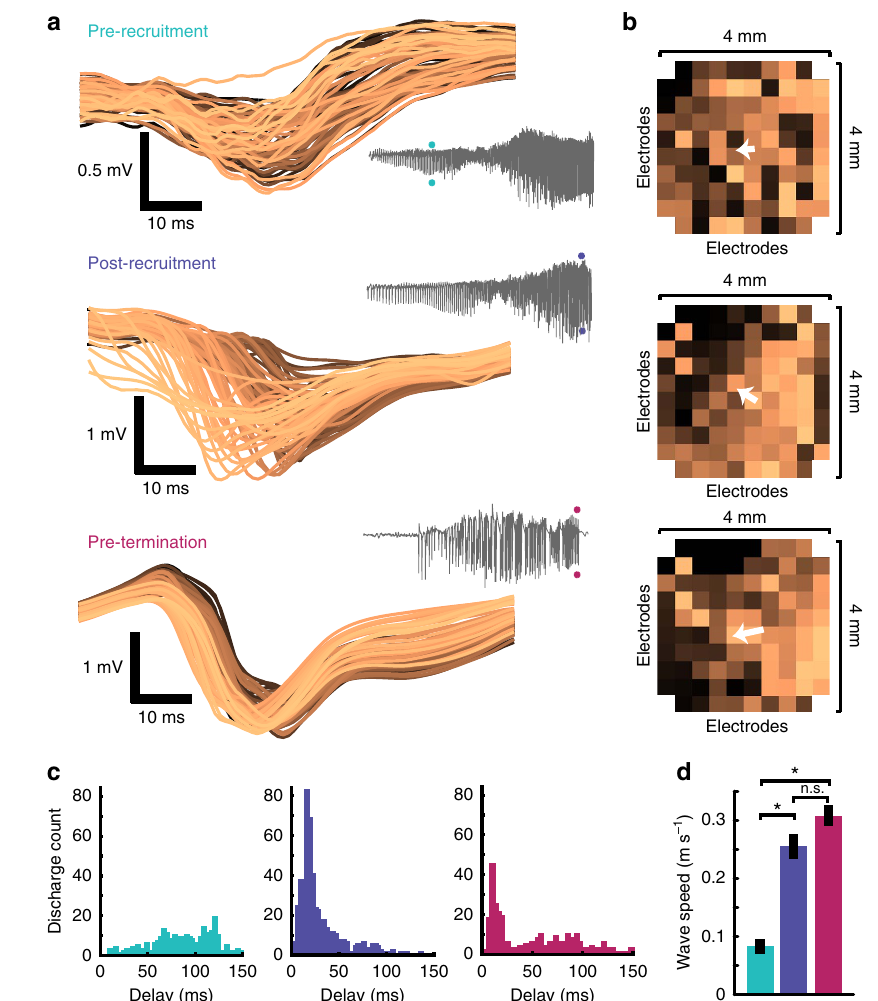
Figure 2 | Ictal discharges form travelling waves across the microelectrode array. ( a ) Example, low-frequency LFP recorded from each microelectrode during three ictal (EEG) discharges, one from each seizure epoch as indicated by the coloured asterisks in the seizure traces, colour coded by when the maximally negative slope of the travelling wave occurs on each microelectrode. Seizures from two patients (patient 3 and 5) are shown. ( b ) The footprint of the microelectrode array corresponding to the three ictal discharges in a , with electrode positions colour coded the same way as the LFP in a . Vectors indicating travelling wave direction are superimposed on the microelectrode array footprint in white. ( c ) Histograms of delays between the first and last discharges on array microelectrodes during each epoch (pre-recruitment in light blue, post-recruitment in purple and pre-termination in pink). ( d ) Measures of discharge speed across all patients, during the three epochs shown in a . Post hoc Tukey’s range test determined that pre-recruitment bursts ( N ¼ 273) were significantly slower than both post-recruitment ( N ¼ 315) and pre-termination ( N ¼ 282) bursts ( P ¼ 9.5 (cid:2) 10 (cid:3) 10 and P ¼ 9.5 (cid:2) 10 (cid:3) 10 ). Post-recruitment and pre-termination bursts did not exhibit significantly different speeds ( P ¼ 0.82). Error bars indicate